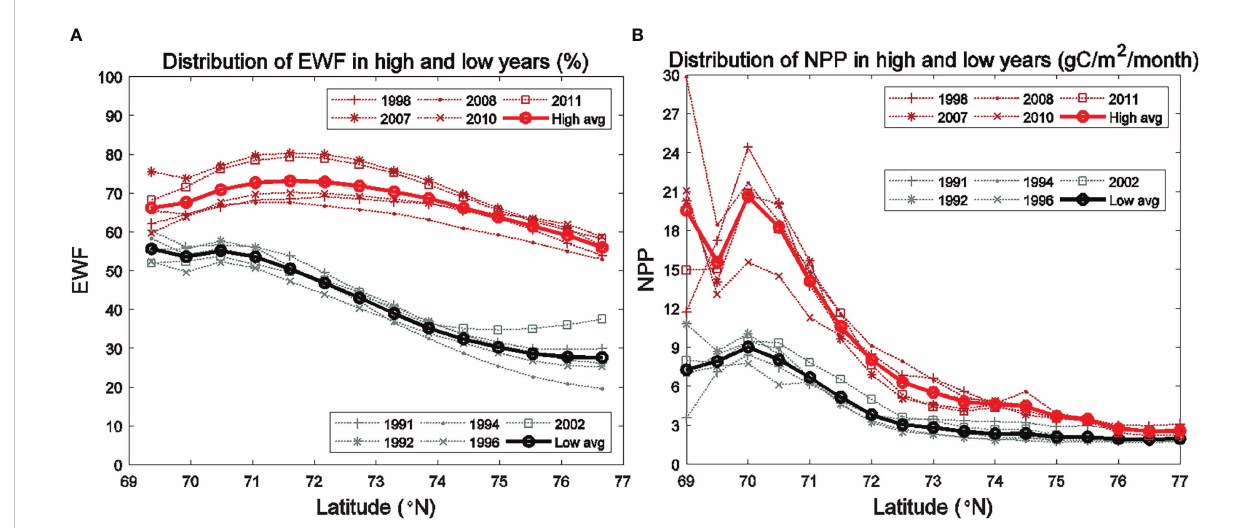
FIGURE 9 Seasonally (June to September) averaged (A) EWF and (B) modeled vertically-integrated NPP for the high (1998, 2007, 2008, 2010, 2011) and low (1991, 1992, 1994, 1996, 2002) EWF years in the